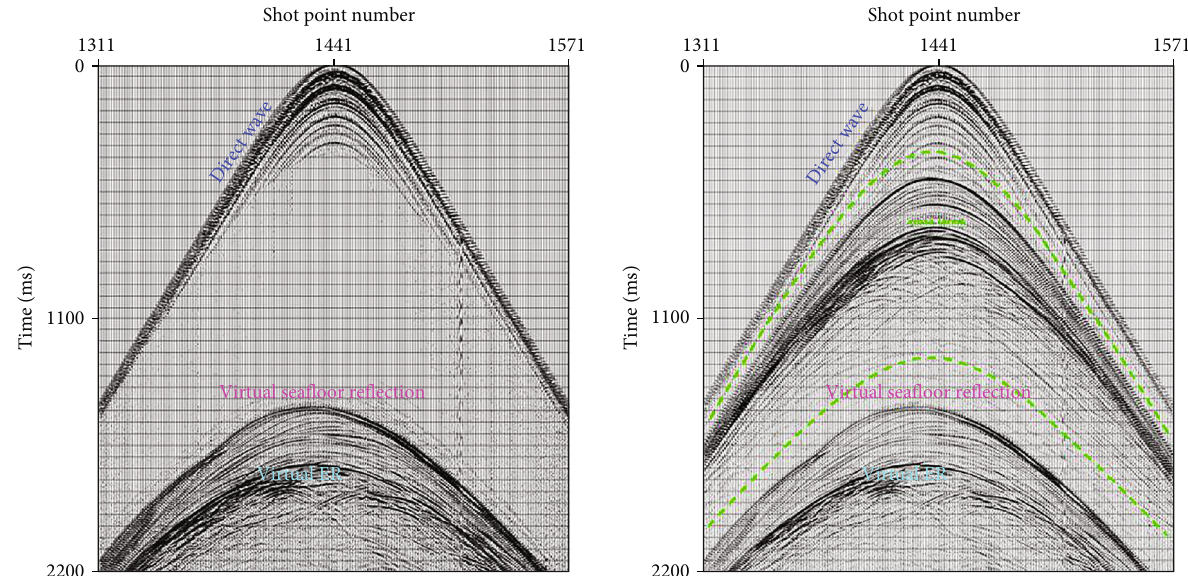
Figure 5: Interferogram ((a) cross-correlation of the direct wave with ghost waves and (b) cross-correlation of the direct wave with all waves).